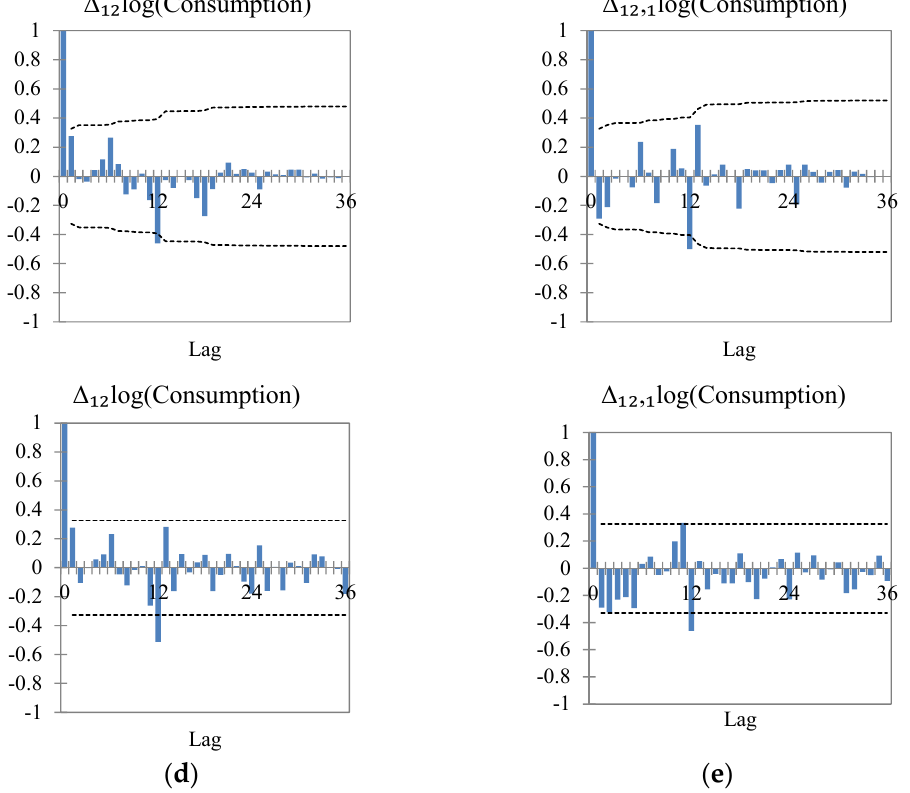
Figure 4. ACF and PACF plots of logged transformed consumption with differenced values for: ( a ) None; ( b ) Δ log; ( c ) Δ ²log; ( d ) Δ₁₂ log; ( e ) Δ₁₂ , ₁ log of consumption.